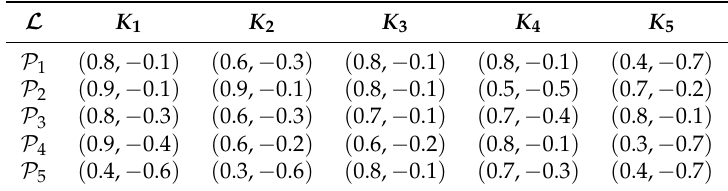
Table 5. Bipolar fuzzy decision